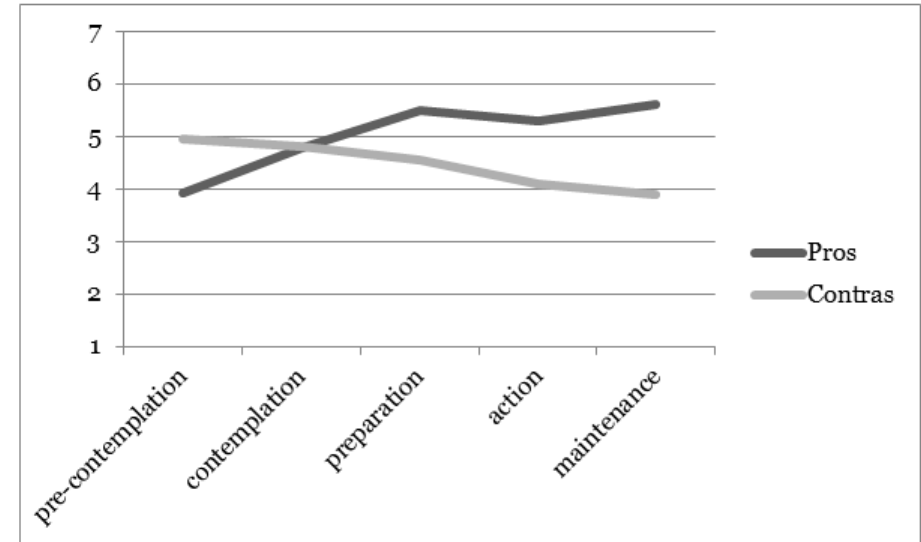
Figure 2. Pros and cons across the stages-of-change